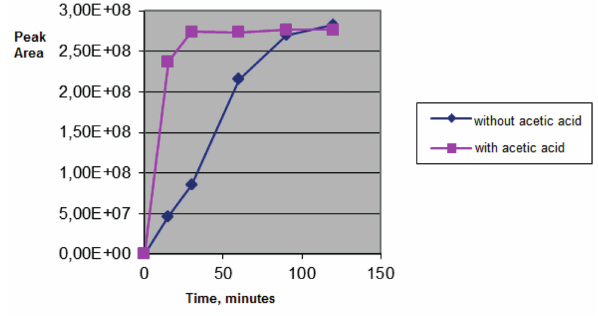
Figure 2: Comparative evolution of the eprinomectin derivatization process; with or, without acetic acid.